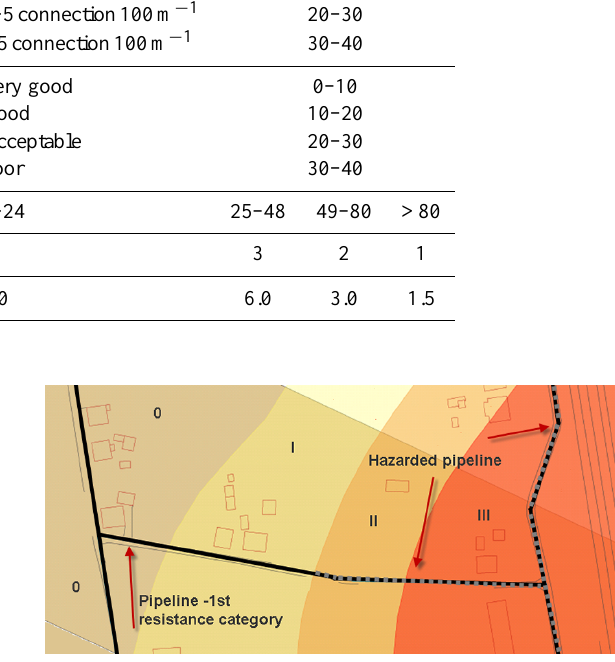
Figure 1. Example of the course of a linear object through terrains of belonging to different terrain categories (0, I, II, and III represent different terrain categories, with III being the most